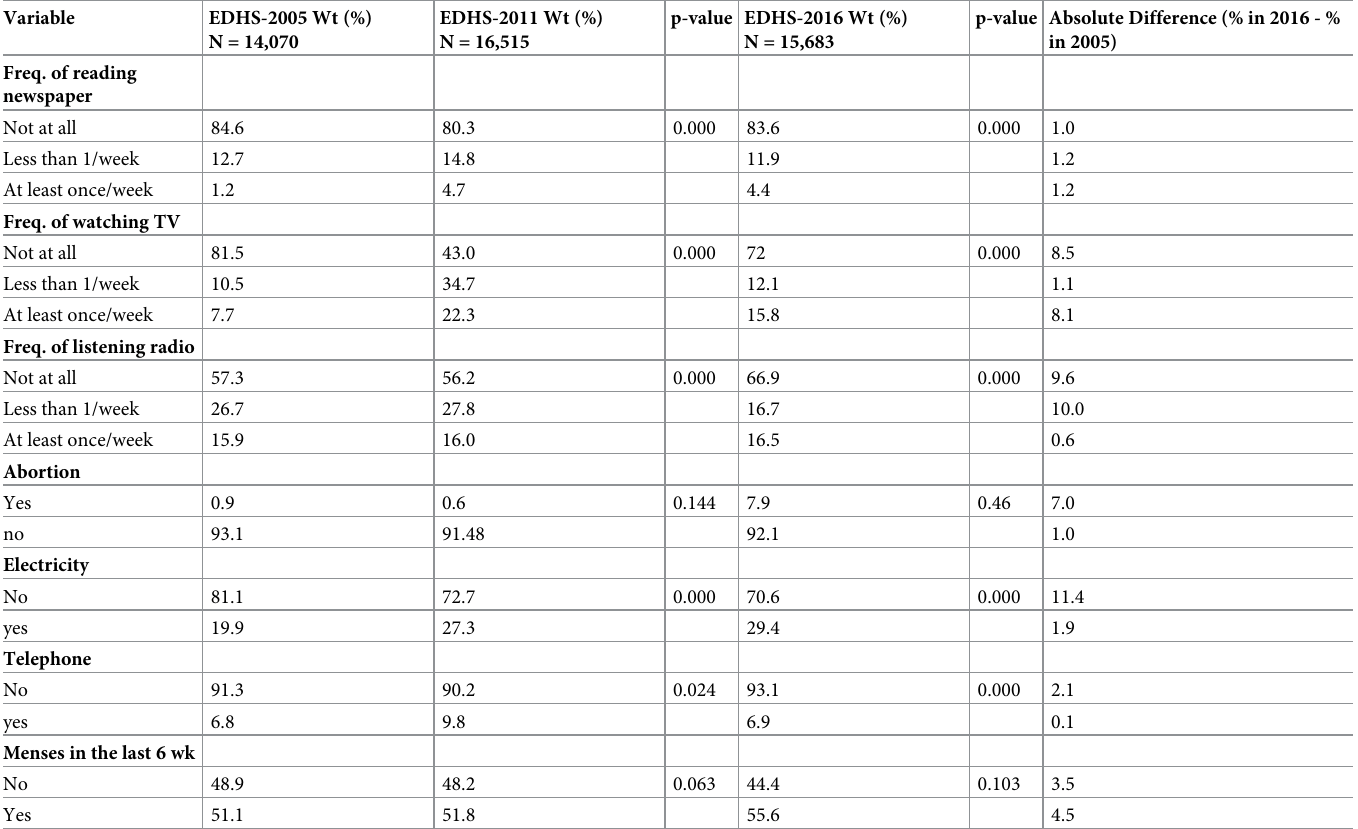
Table 2. Reproductive health and source of information the study participants EDHS 2005-2016(N = 46,268). Variable